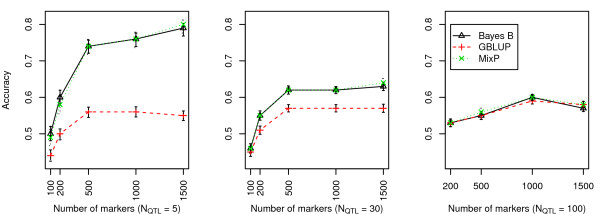
Comparison of accuracies of BayesB, GBLUP, and MixP with a heritability per chromosome = 0.03.